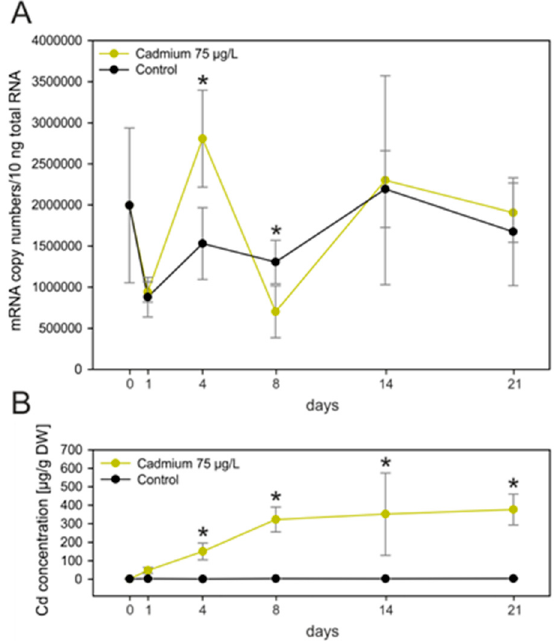
Figure 5. ( A ) MT induction pattern in the midgut gland of untreated individuals (black line) and individuals exposed to cadmium (75 µg/L) (yellow line) of Biomphalaria glabrata over a period of 21 days. Means and standard deviations are shown ( n = 4). The course of MT mRNA transcription was tested by two-way analysis of variance (ANOVA) ( p ≤ 0.05) but was insignificant. Stars indicate significant differences at single time points according to multiple t -test comparisons; ( B ) cadmium concentration in the midgut gland of Biomphalaria glabrata from controls (black line) and exposed individuals (75 µg/L Cd) (yellow line). Means and standard deviations are shown ( n = 4). Two-way ANOVA ( p ≤ 0.05) revealed significant differences between the two treatments. Stars indicate significant differences at single time points according to multiple t -test comparisons.